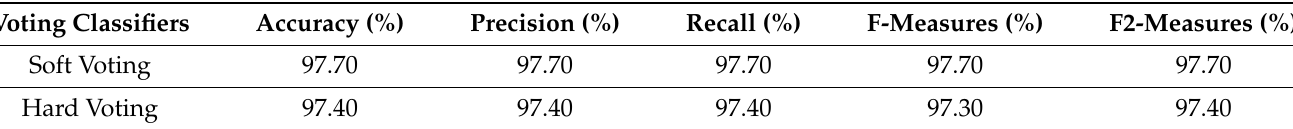
Table 5. Evaluation results of ensemble voting after pre-processing by using the wrapper features subset selection